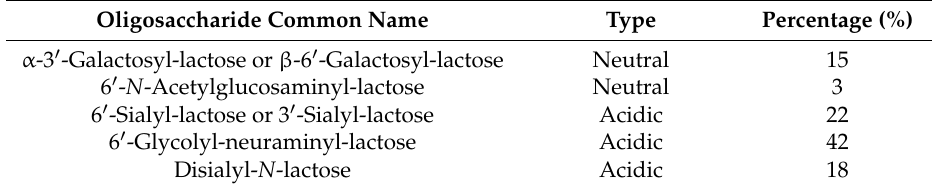
Table 2. Abundance of oligosaccharides as a percentage of total oligosaccharides present in the CMOF. Oligosaccharide Common